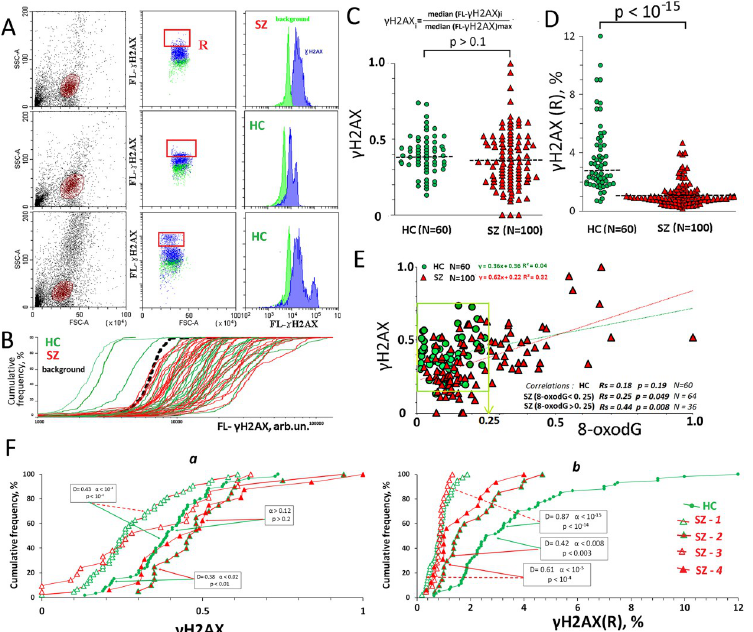
Fig 3. ɣ H2AX levels in the lymphocyte of the SZ group and HC group. A. The most typical examples of the ɣ H2AX analysis in lymphocytes. B. Cumulative distribution of FL1- ɣ H2AX for 60 randomly selected HC (green) and SZ (red) samples in a one experiment. The dashed curve is the background curve for the sample with the maximum background level. C. ɣ H2AX levels in the lymphocyte of the SZ- and HC groups. The average level of marker in the cell population was estimated by the FL-signal median value. In the graphs, each point is the mean for three FL-signal median values (three parallel measurements for the same PBMC sample). The median values were normalized to the maximum signal medians values in the analyzed total sample (N = 160). The relative standard error was 5 ± 3%. The significance of the observed differences was analyzed using non-parametric Mann–Whitney (p) test. D. ɣ H2AX(R) levels in the lymphocyte of the SZ- and HC groups. The significance of the observed differences was analyzed using non-parametric Mann–Whitney (p) test. E. The dependence of ɣ H2AX on 8-oxodG . Linear regression data is shown at the top left of the graph. At the bottom right of the graph, italics show the correlation analysis data for the SZ subgroups and HC group. F. (a) Cumulative distribution of ɣ H2AX for HC and SZ subgroups. (b) Cumulative distribution of ɣ H2AX(R) for HC and SZ subgroups. Arrows indicate compared subgroups. The significance of the observed differences was analyzed using the non-parametric Mann–Whitney test (p) and Kolmogorov–Smirnov test (D and α